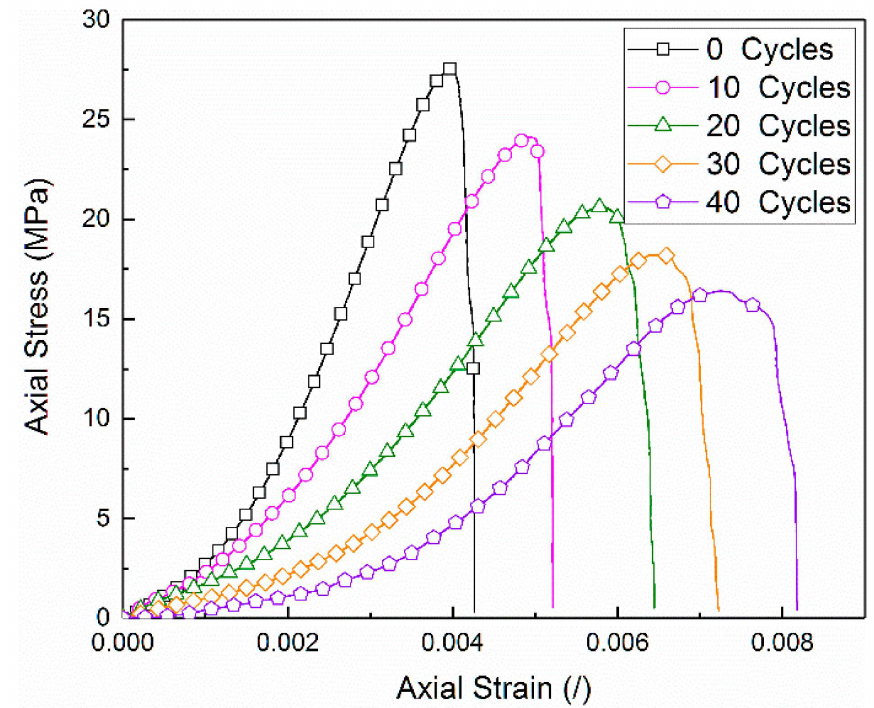
Figure 6. Stress–strain curves for sandstone specimens after undergoing different quantities of F&T weathering cycles in uniaxial compression